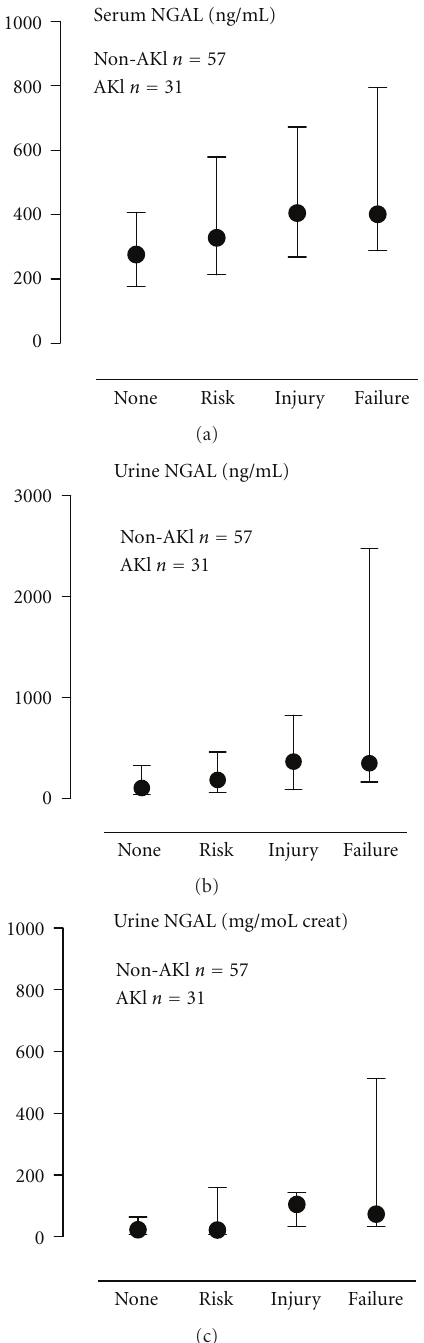
Figure 1: Neutrophil gelatinase-associated lipocalin (NGAL) in serum and urine per RIFLE severity. On nonacute kidney injury (AKI) days NGAL in serum and urine was lower ( P < 0 . 05) compared with days fulfilling the RIFLE RISK , RIFLE INJURY , and RIFLE FAILURE criteria. Non-AKI patients, N = 57; AKI patients N = 31.